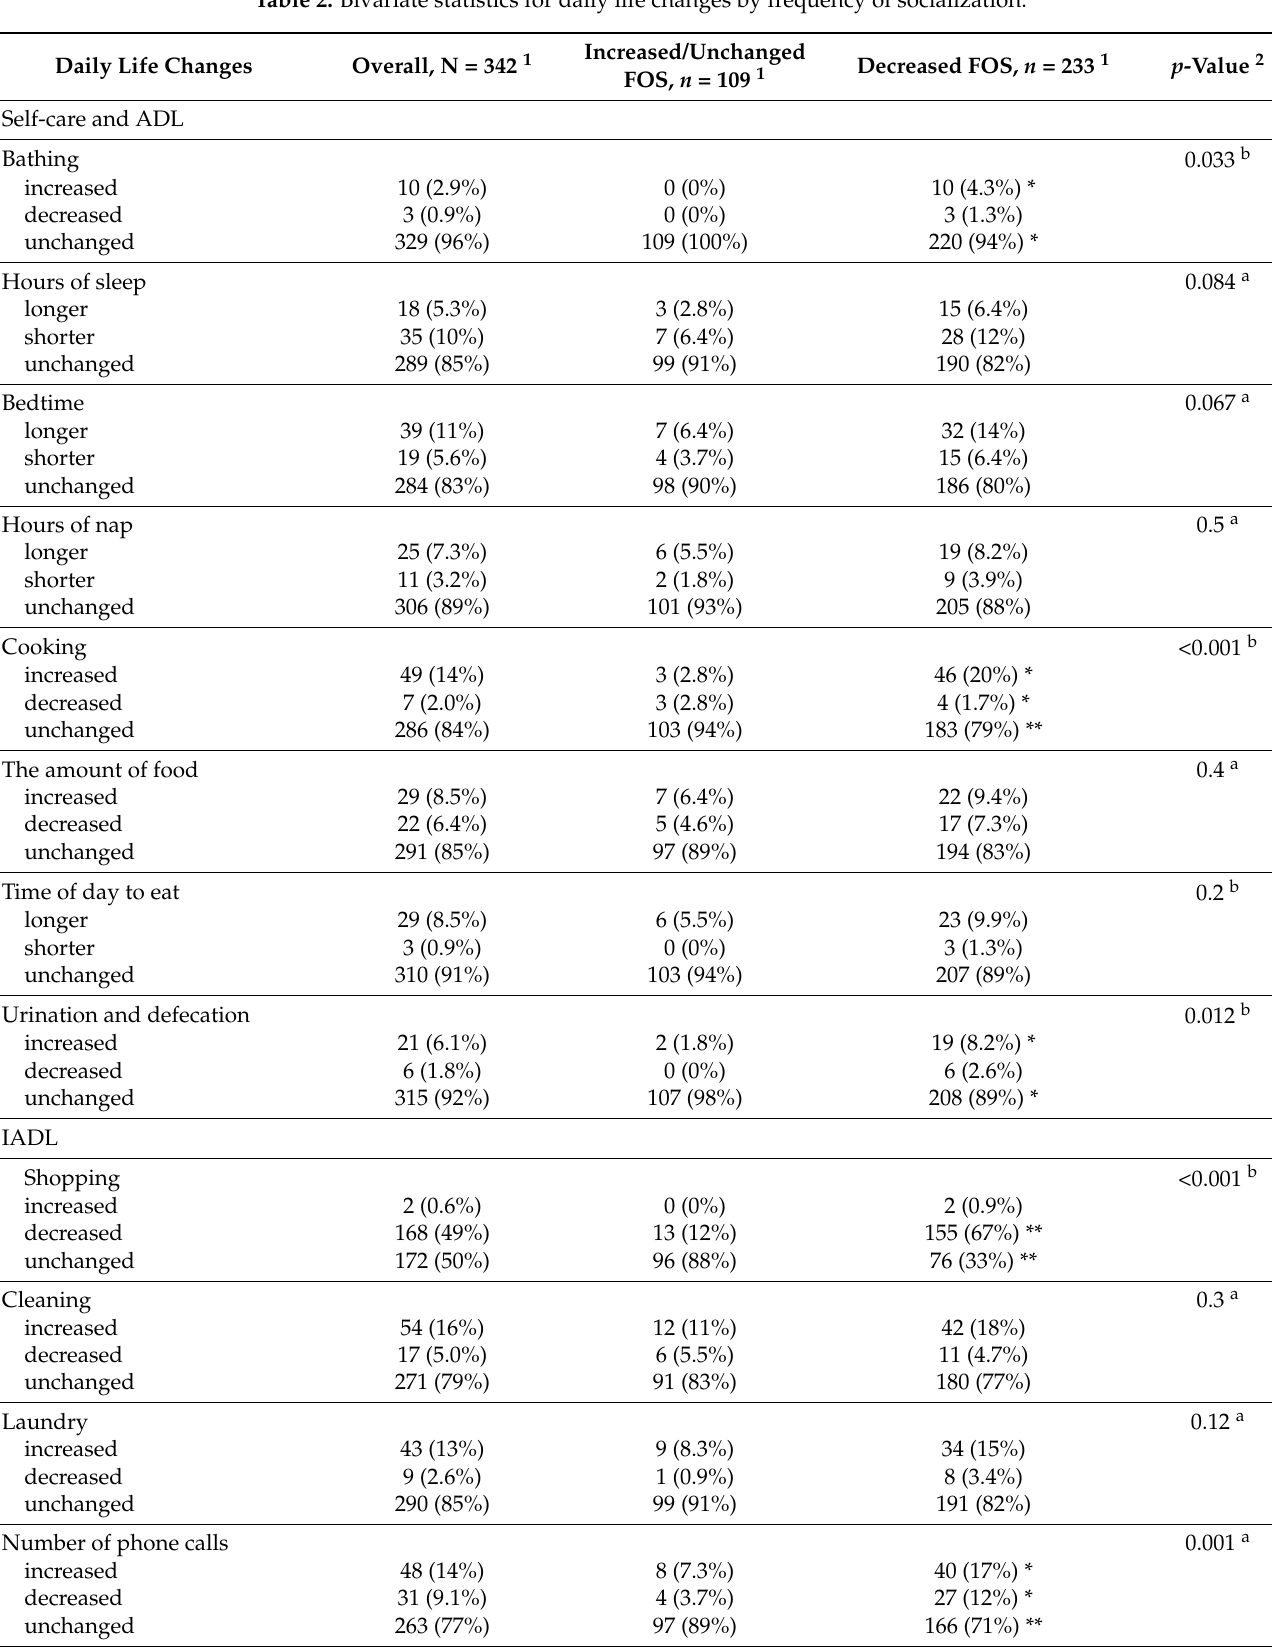
Table 2. Bivariate statistics for daily life changes by frequency of